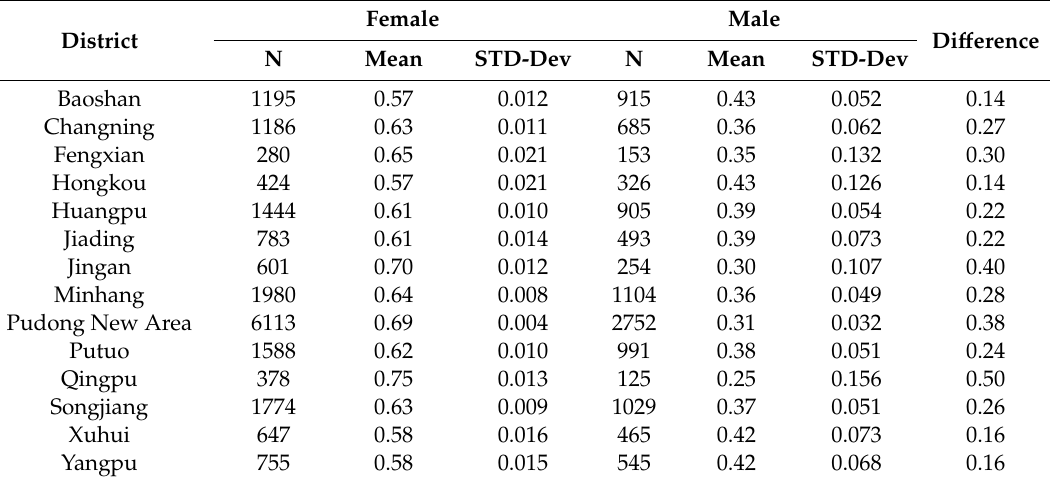
Table 9. Summary statistics in